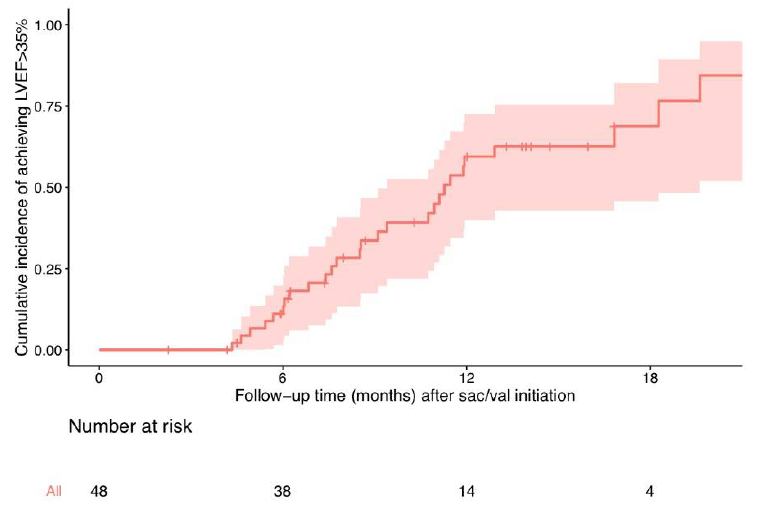
Figure 1. Cumulative incidence of reaching left ventricular ejection fraction (LVEF) above 35%. Sac/val = sacubitril/valsartan.